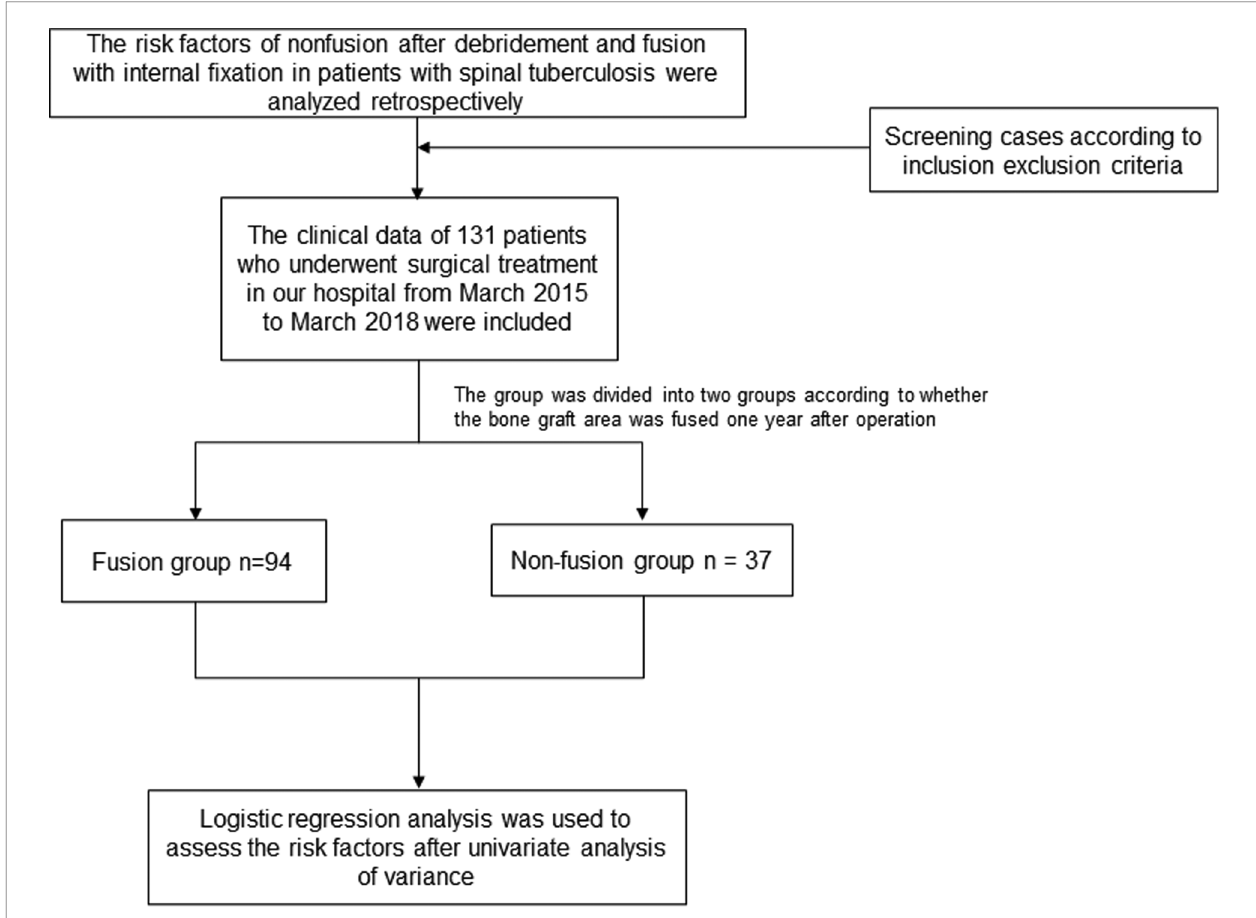
FIGURE 1 | Study design and fl ow diagram of this